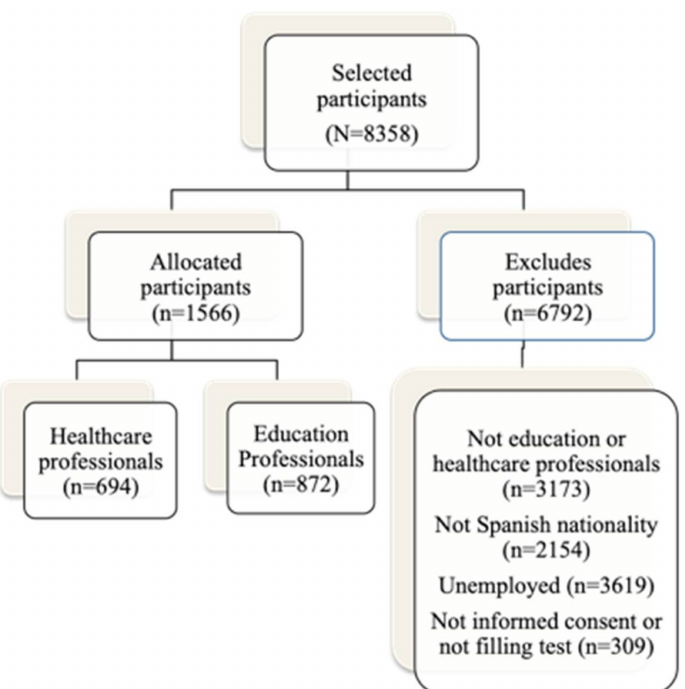
Figure 1. Sample selection